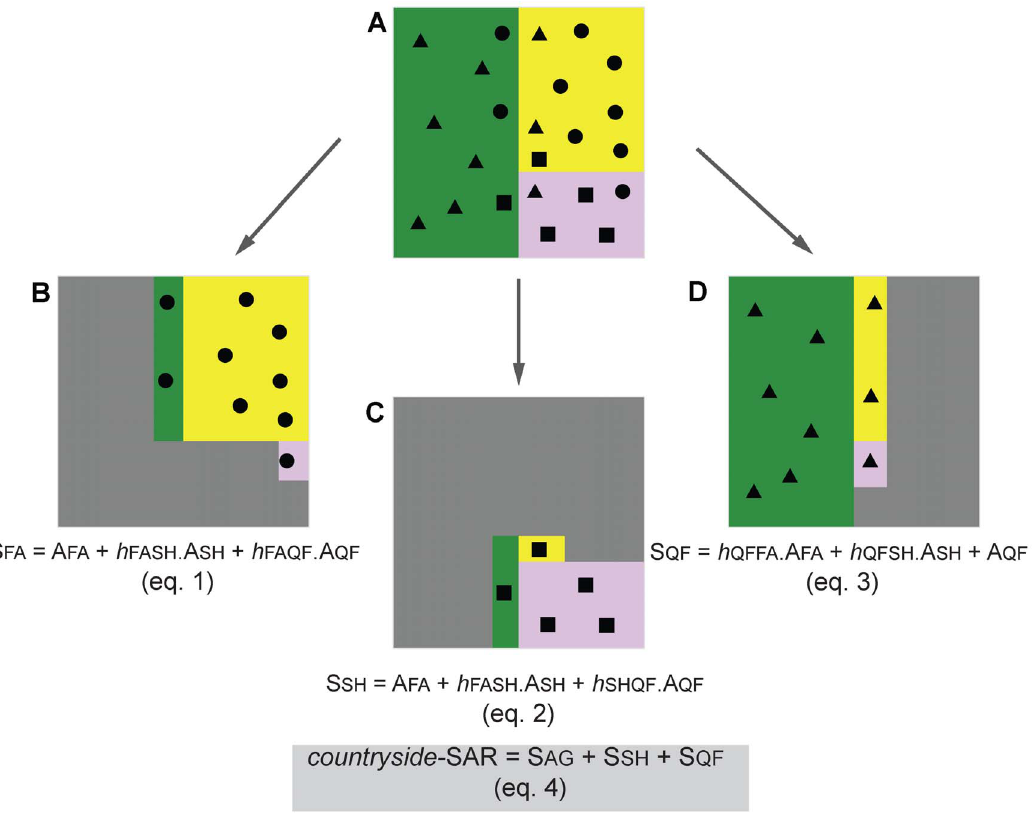
Figure 3. Schematic representation of the countryside-SAR model. The countryside-SAR estimates the total number of species in the landscape accounting for a differential use of habitats by different species groups. The conceptual landscape (A) is composed by different proportions of farmland (FA; yellow), shrubland (SH; rose) and oak forest (QF; green); this landscape is used by farmland (dots), shrubland (squares) and forest (triangles) species. For each species group (B, C and D) the model estimates the affinity of the group h , to each of the habitats; the affinity can be interpreted as the proportion of area of each habitat that can be effectively used by a species group (eq. 1, 2 and 3 respectively). The total number of species in the multi-habitat landscape is given by the sum of the number of species in each group (eq. 4).